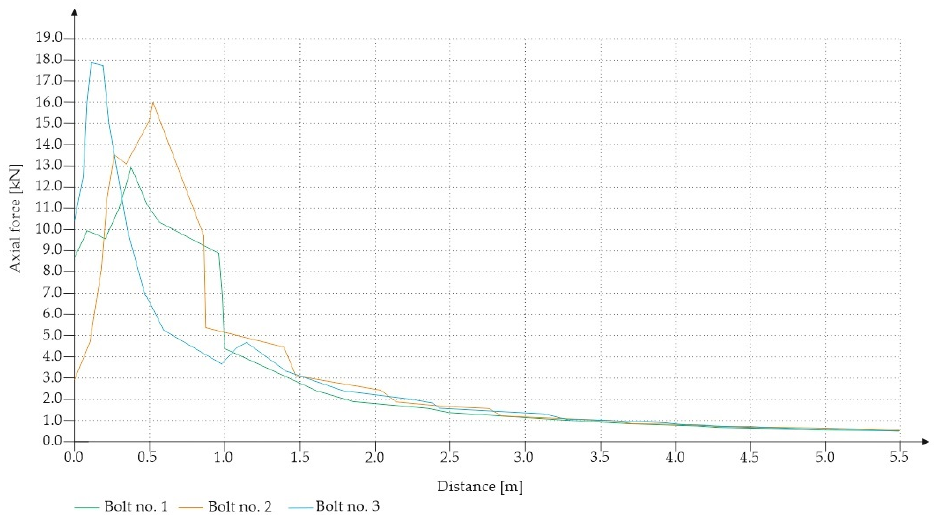
Figure 13. Maximum axial force in full-length anchors for Vernier excavation (Hoek–Brown criterion).